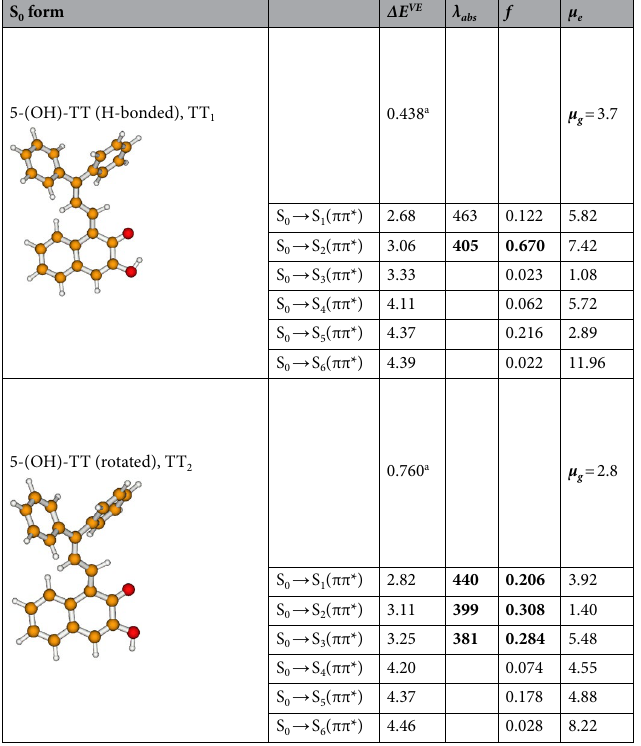
Table 1. Vertical excitation energy, ΔE VE (in eV) and λ abs (in nm), oscillator strength, f , and dipole moment, μ e (in Debye), of the lowest excited singlet states calculated with the CC2/aug-cc-pVDZ method for the 5-(OH)-NP ground state equilibrium forms optimized at the MP2/cc-pVDZ theory level. Dipole moment of the ground-state, μ g (in Debye, MP2/cc-pVDZ). a Difference in adiabatic energy (E a , in eV) relative to the closed form, CF 1 , calculated at the MP2/cc-pVDZ theory level. Significant values are in [bold].